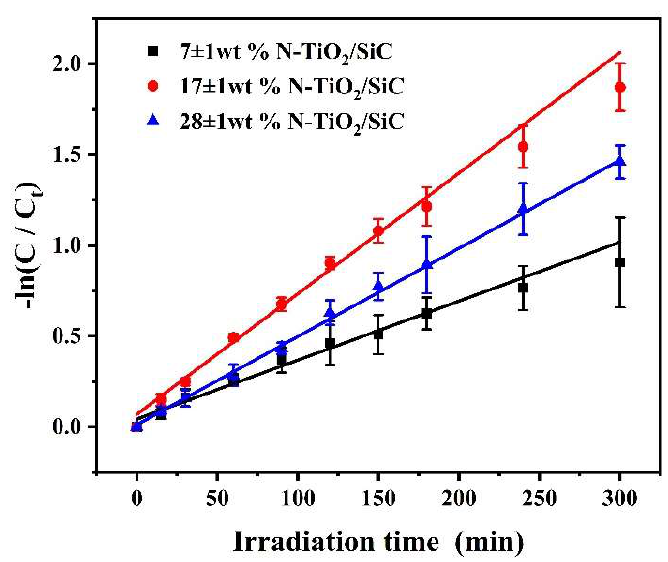
Figure 9. Effect of catalyst loading on MB photodegradation kinetics.